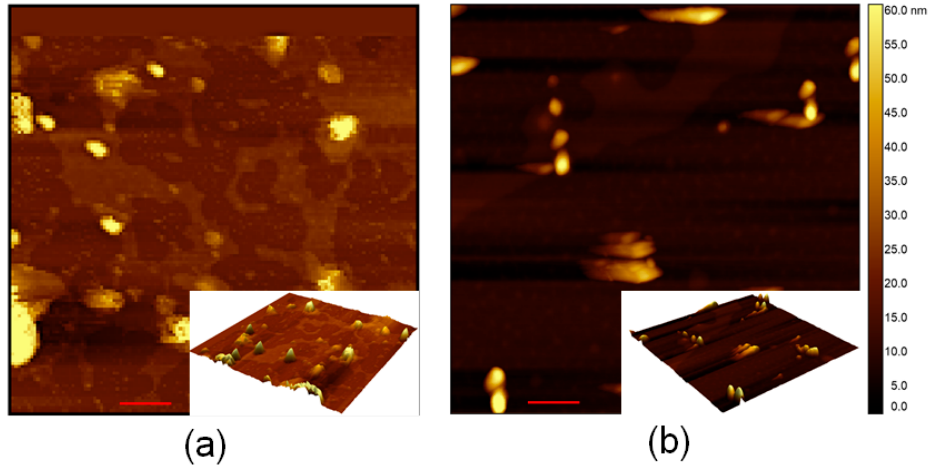
Figure 5. Atomic force microscopy of rTHOP-GNP and rNEL-GNP. Atomic force microscopy (AFM) measurement of ( a ) rTHOP-GNP and ( b ) rNEL-GNP 2D images are observable (red scale bar = 200 nm) as the central figure and 3D rendering of as insets of ( a , b ) for rTHOP-GNP and rNEL-GNP,